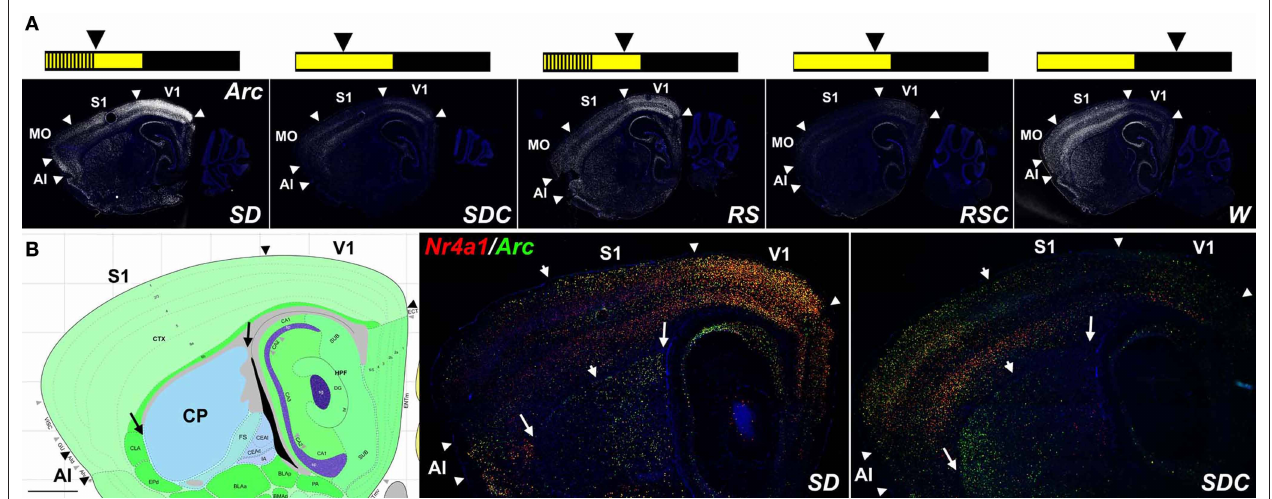
cellular colocalization of these two mRNAs (yellow cells). Arrowheads in (A) and (B) delineate major cortical areas, large arrows in (B) delineate the boundaries of the caudate putamen (CP)and arrowheads in (B) divide zones of higher rostral (left in SD) or caudal (right in SDC) IEG expression in the CP and neocortex. Left panel in (B) is an annotated reference atlas panel (Dong, 2008), plane-matched to the ISH images (right panels). All sections were counterstained with DAPI (blue). AI, agranular insular cortex; MO, motor cortex somatomotor cortex; S1, primary somatosensory cortex; V1, primary visual cortex. Scale bars: 1